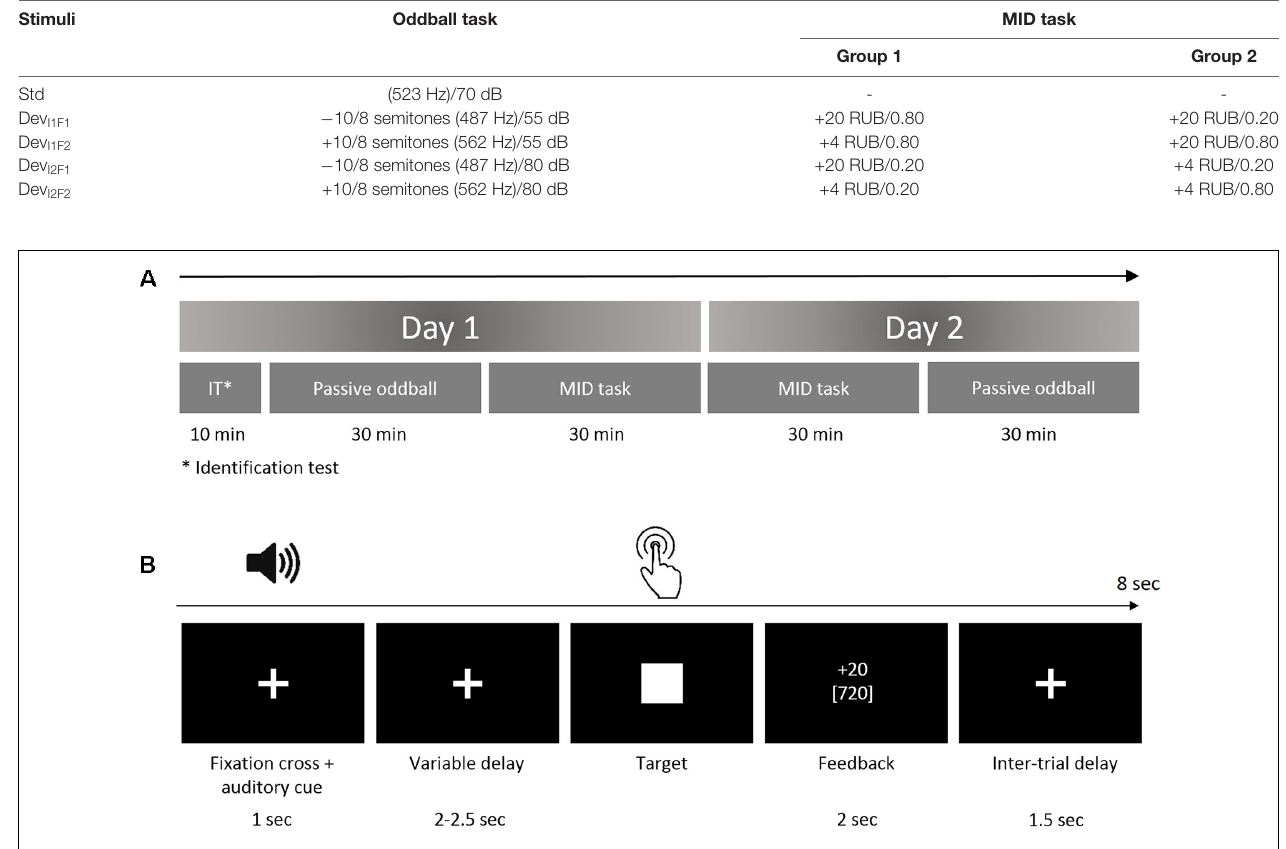
TABLE 1 | Acoustic stimuli in the oddball task and monetary incentive delay (MID) task. Stimuli